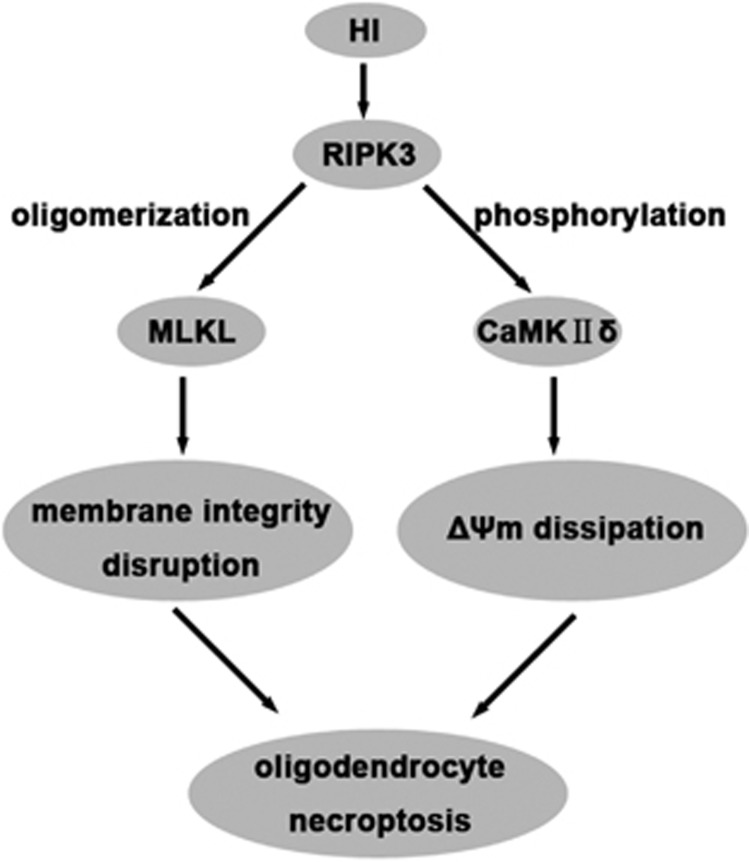
Summary of the mechanisms underlying RIPK3-mediated OPCs death induced by HI